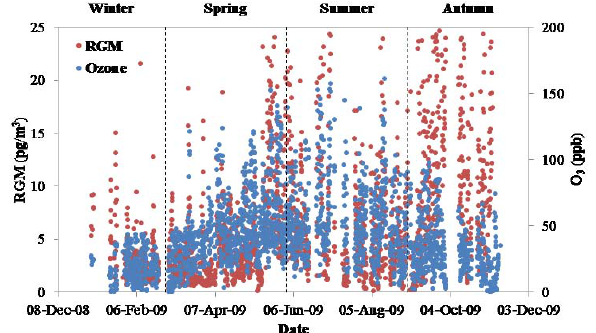
Fig. 7. Comparison of O 3 and RGM concentrations in different sea-